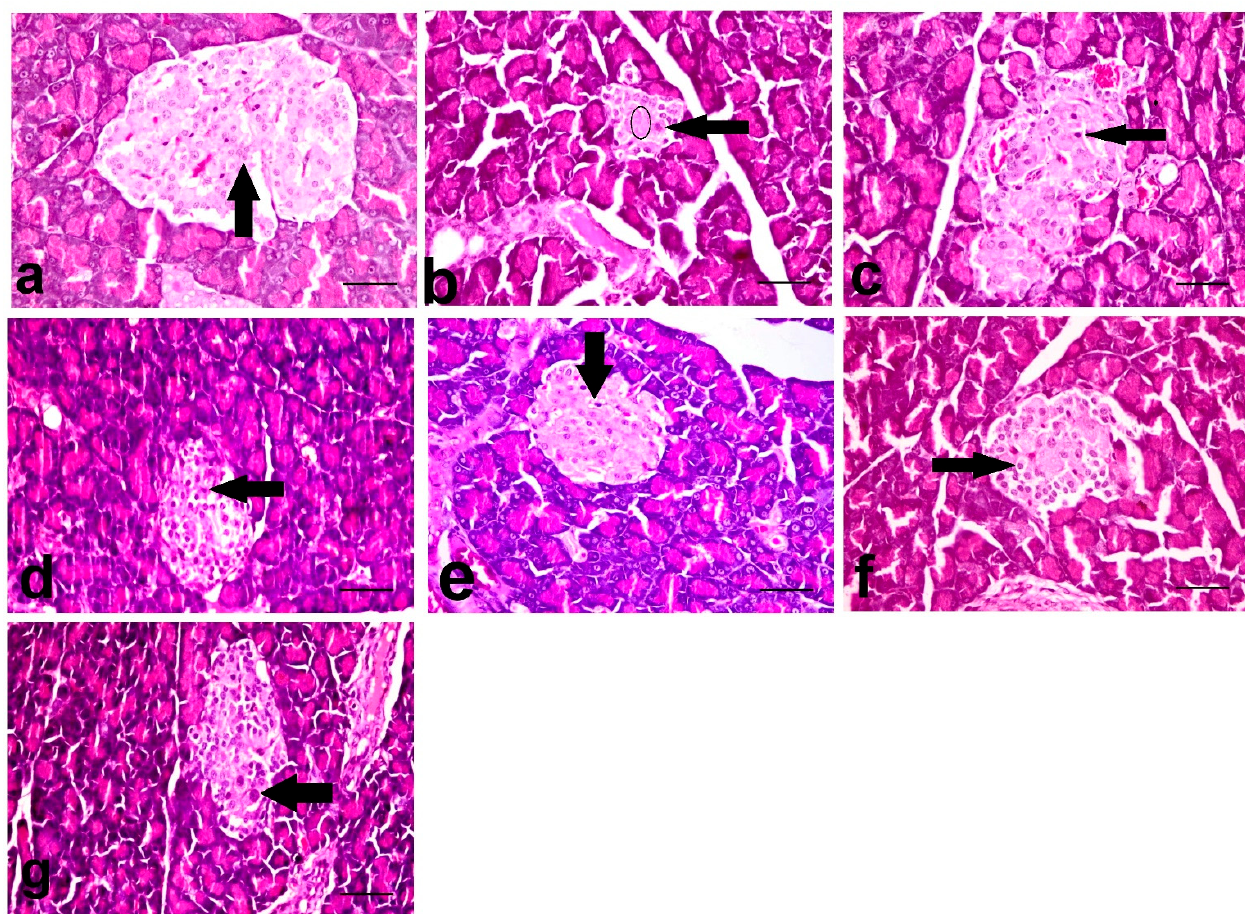
Figure 1. The histopathological photomicrographs of the pancreases. ( a ) NC group showing normal β -cells (arrow) ( b ) STZ-control group showing marked decrease in the number (circle), necrosis (arrow) and apoptosis of β -cells, and distortion of the islet. ( c ) STZ + GLB and ( d ) STZ + AJE-250 showing increase in the number of β -cells with necrosis (arrow) and vacuolation of some cells. ( e ) STZ + AJE-500 and ( f ) STZ + GLB + AJE-250 showing moderate improvement of the β -cells with individual cell necrosis (arrow). ( g ) STZ + GLB + AJE-500 group showing single cell necrosis of β -cells (arrow); scale bar, 25 µm.